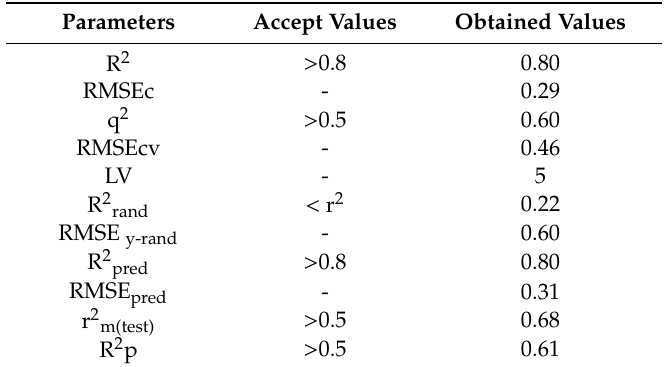
Table 3. Statistical parameters evaluated in the analysis.